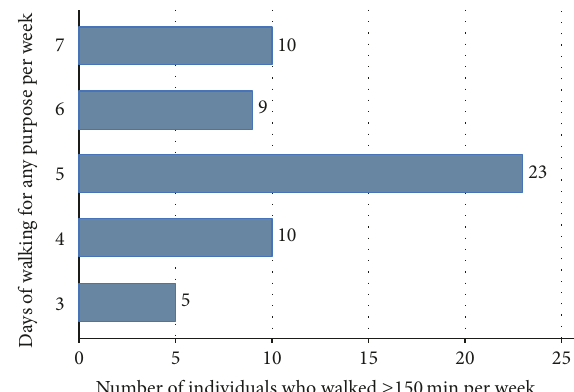
Figure 1: Number of days of walking for any purpose by middle- aged and older overweight and obese individuals who walked ≥ 150 minutes per